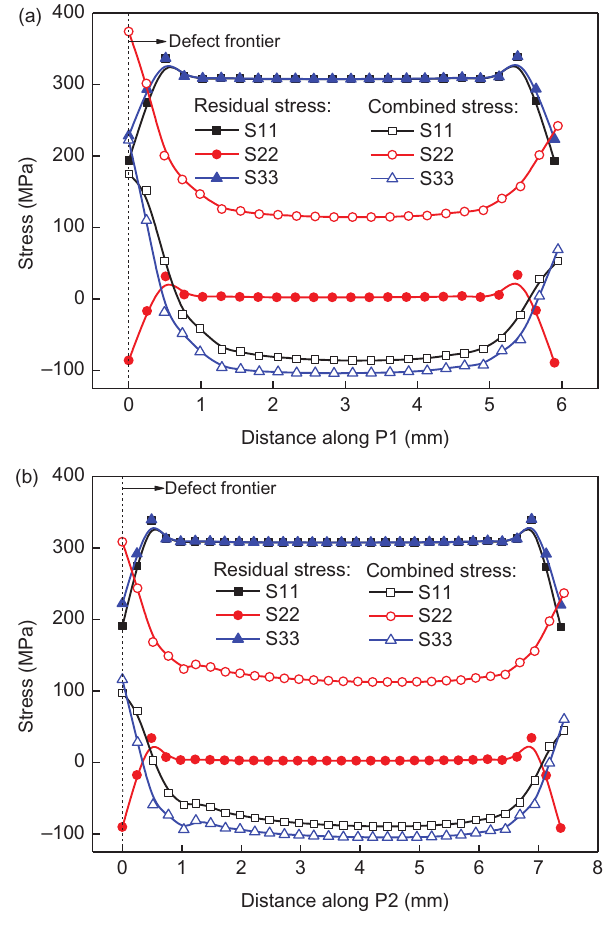
Figure 8: The stress distribution in defect section for semicircular (a) and straight (b)